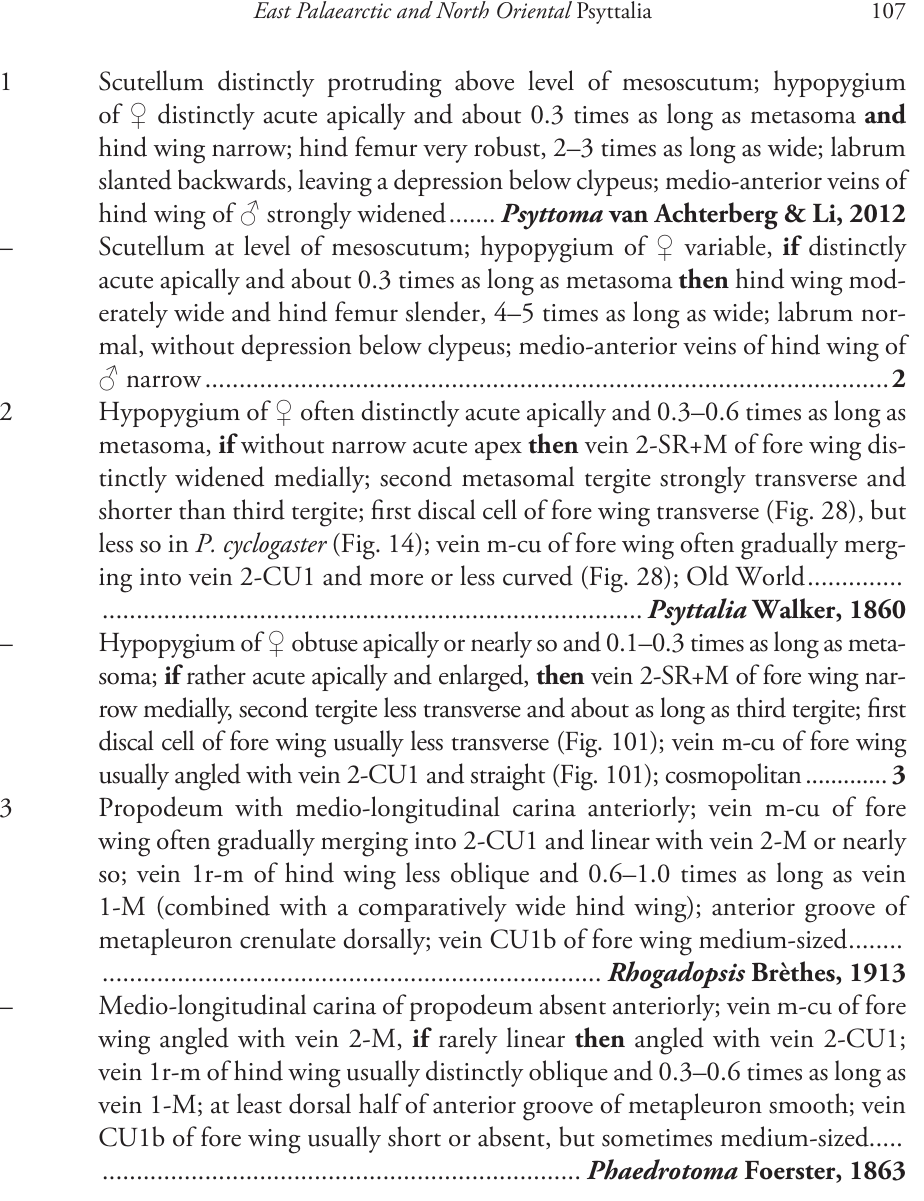
Scutellum distinctly protruding above level of mesoscutum; hypopygium of ♀ distinctly acute apically and about 0.3 times as long as metasoma and hind wing narrow; hind femur very robust, 2–3 times as long as wide; labrum slanted backwards, leaving a depression below clypeus; medio-anterior veins of hind wing of ♂ strongly widened ....... Psyttoma van Achterberg & Li, 2012 – Scutellum at level of mesoscutum; hypopygium of ♀ variable, if distinctly acute apically and about 0.3 times as long as metasoma then hind wing mod- erately wide and hind femur slender, 4–5 times as long as wide; labrum nor- mal, without depression below clypeus; medio-anterior veins of hind wing of ♂ narrow .................................................................................................... 2 2 Hypopygium of ♀ often distinctly acute apically and 0.3–0.6 times as long as metasoma, if without narrow acute apex then vein 2-SR+M of fore wing dis- tinctly widened medially; second metasomal tergite strongly transverse and shorter than third tergite; first discal cell of fore wing transverse (Fig. 28), but less so in P. cyclogaster (Fig. 14); vein m-cu of fore wing often gradually merg- ing into vein 2-CU1 and more or less curved (Fig. 28); Old World .............. ............................................................................... Psyttalia Walker, 1860 – Hypopygium of ♀ obtuse apically or nearly so and 0.1–0.3 times as long as meta- soma; if rather acute apically and enlarged, then vein 2-SR+M of fore wing nar- row medially, second tergite less transverse and about as long as third tergite; first discal cell of fore wing usually less transverse (Fig. 101); vein m-cu of fore wing usually angled with vein 2-CU1 and straight (Fig. 101); cosmopolitan ............. 3 3 Propodeum with medio-longitudinal carina anteriorly; vein m-cu of fore wing often gradually merging into 2-CU1 and linear with vein 2-M or nearly so; vein 1r-m of hind wing less oblique and 0.6–1.0 times as long as vein 1-M (combined with a comparatively wide hind wing); anterior groove of metapleuron crenulate dorsally; vein CU1b of fore wing medium-sized ........ ......................................................................... Rhogadopsis Brèthes, 1913 – Medio-longitudinal carina of propodeum absent anteriorly; vein m-cu of fore wing angled with vein 2-M, if rarely linear then angled with vein 2-CU1; vein 1r-m of hind wing usually distinctly oblique and 0.3–0.6 times as long as vein 1-M; at least dorsal half of anterior groove of metapleuron smooth; vein CU1b of fore wing usually short or absent, but sometimes medium-sized..... ...................................................................... Phaedrotoma Foerster, 1863 Key to East Palaearctic and North Oriental species of the genus Psyttalia Walker 1 Scutellum medio-posteriorly densely setose and micro-sculptured, and slight- ly protruding or pinched subposteriorly (Figs 16, 17); vein m-cu of fore wing distinctly postfurcal (Fig. 14) to subinterstitial; area behind stemmaticum with a small pit and in front of anterior ocellus with a smooth protuberance (Figs 20, 21; often absent or obsolescent in small specimens); propodeum largely finely rugose (Fig. 17); [hind femur 3.5–4.2 times as long as wide